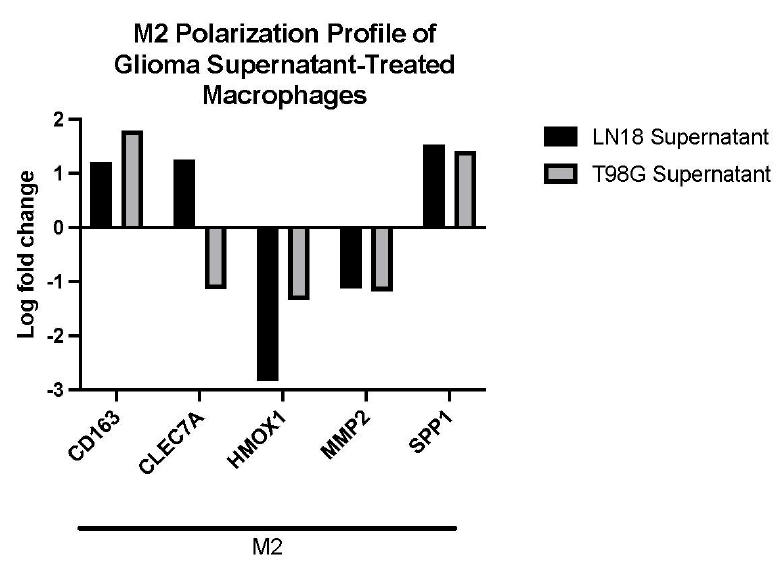
Figure 5. Histogram of differentially expressed genes involved in M2 macrophage polarization in either macrophages treated with supernatant exposed to LN-18 or T98G glioma cells. No M1 genes were found to be significantly differentially expressed.